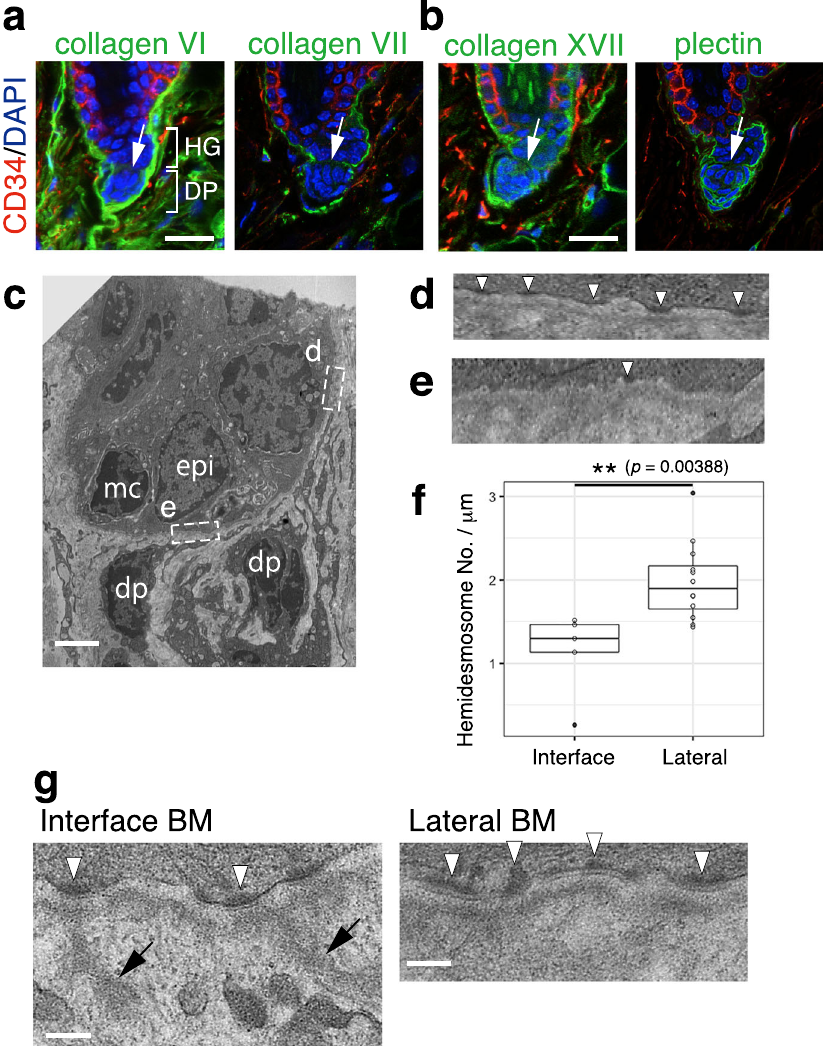
Fig. 6 Unique molecular and structural properties of hair germ and dermal papilla interface. Immunolocalizations of reticular lamina-related ECMs, COL6 and COL7 ( a ), and hemidesmosomal components, COL17 and plectin ( b ), in dorsal telogen HFs. These ECMs and plectin (green) were co-stained with CD34 (red) and DAPI (blue). White arrows indicate the interface between hair germ (HG) and dermal papilla (DP). c Transmission electron microscopy (TEM) image of HG and DP region. epi epidermal HG cell, mc melanocyte, dp DP cell. d , e Magni fi ed images of HG – basement membrane (BM) adhesion sites located at the lateral side ( d ) and interface side ( e ) of the HG region ( c ). Hemidesmosome structures are indicated by white arrowheads. f Box plot of the hemidesmosome densities of HG cells located at the lateral or interface sides of the HG region. Data are indicated as boxplots where the middle line is the median, the lower and upper hinges correspond to the fi rst and third quartiles, respectively, the whiskers indicate 1.5 interquartile range. ** p < 0.01, Mann – Whitney U test (two tailed). n = 5 interface and 12 lateral regions examined over fi ve different TEM images. g BM protrusions observed at the interface BM. BM protrusions extending into the interstitial space are marked with arrows. Hemidesmosome structures are indicated by